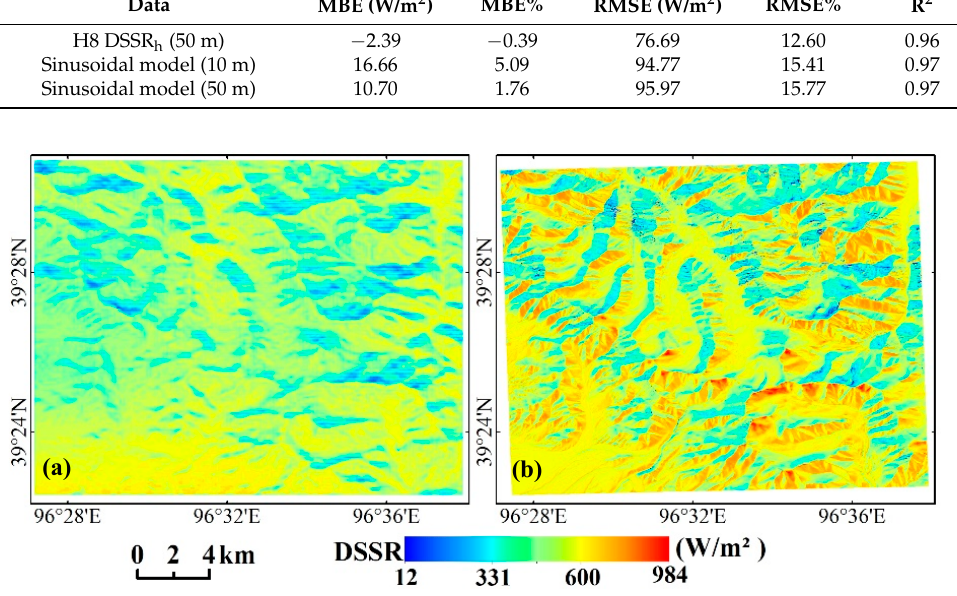
Figure 11. Spatial distribution of the daily average DSSR: ( a ) downscaled DSSR by H8, ( b ) the 10 m daily average DSSR data estimated by the sinusoidal model, respectively.